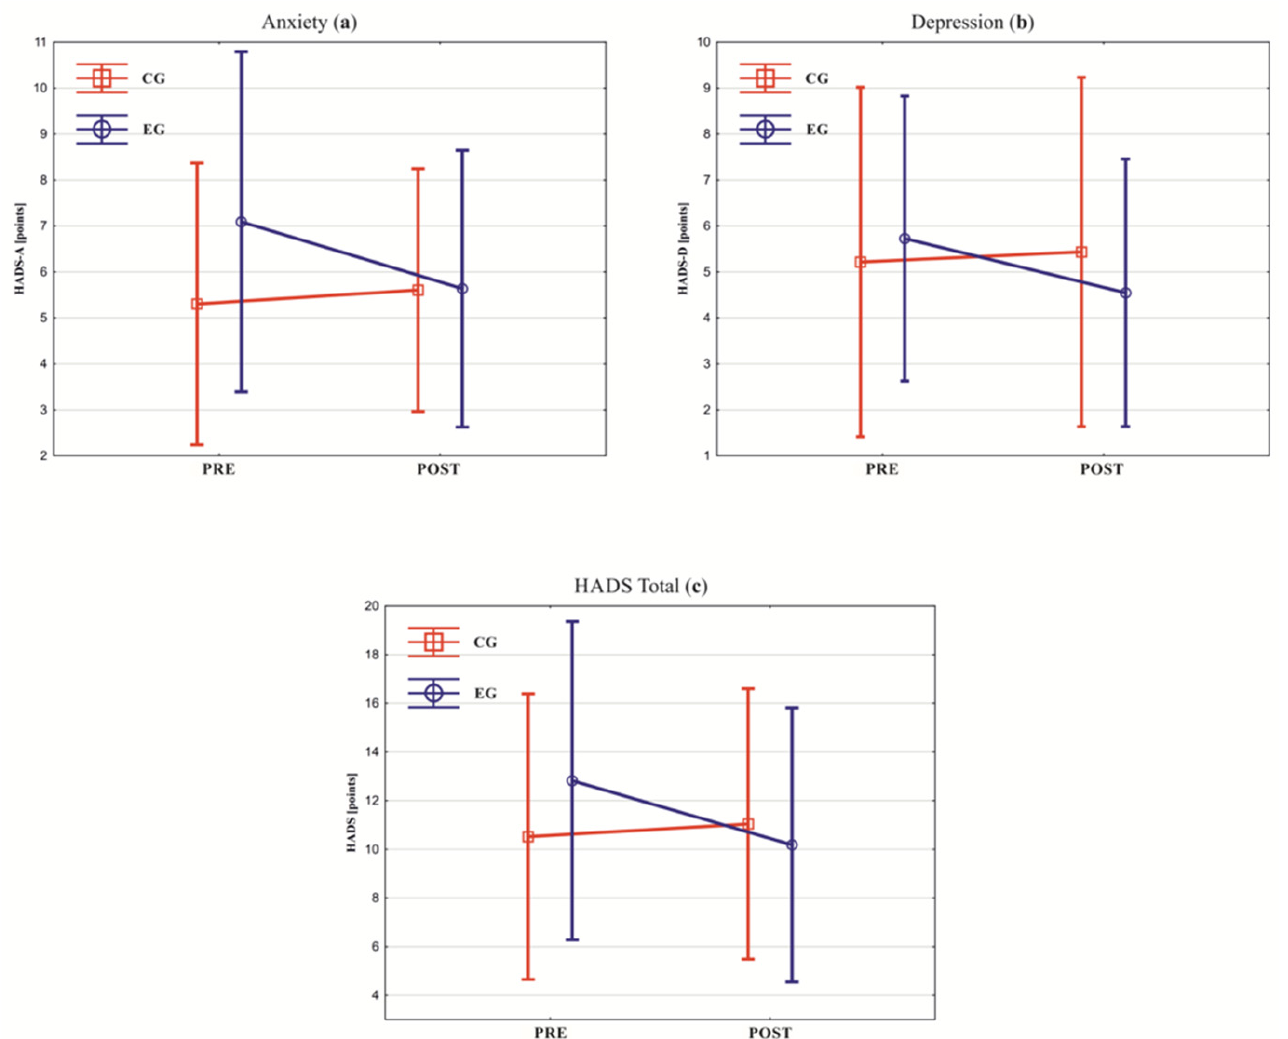
Figure 2. Between-group analysis of the HADS (Hospital Anxiety and Depression Scale) questionnaire scores in pre- and post-rehabilitation: ( a ) anxiety, ( b ) depression, and ( c ) total score. CG—control group; EG—experimental group. Squares and circles show the mean, vertical lines show standard deviations, and slanted lines show the direction of between-group measurements change of the mean values.